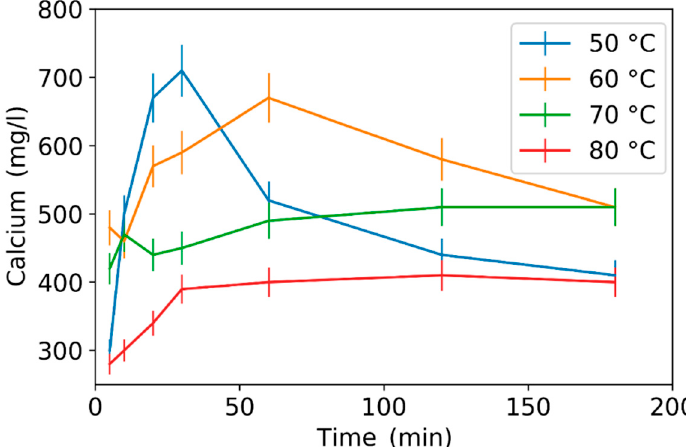
Figure 12. Calcium concentrations as a function of time at 420 g / L S / L using hydrogen peroxide as reducing agent.